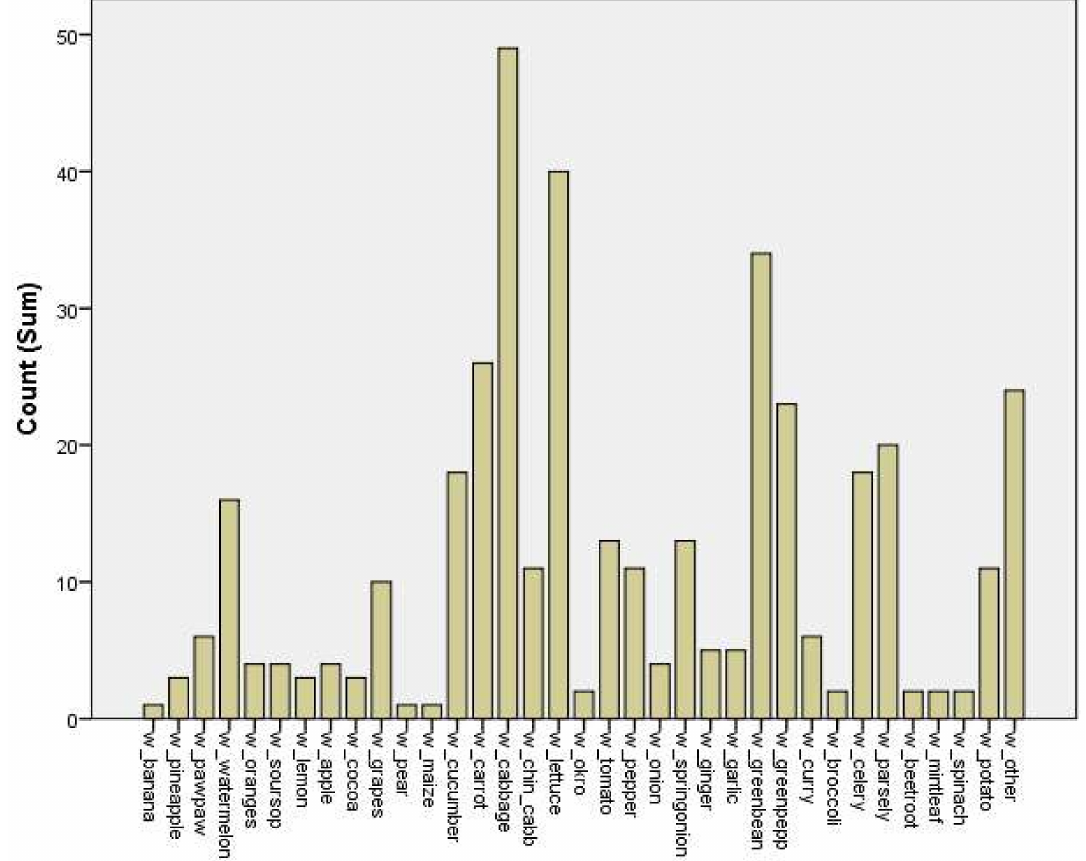
Figure 2. Availability of waste at D-line